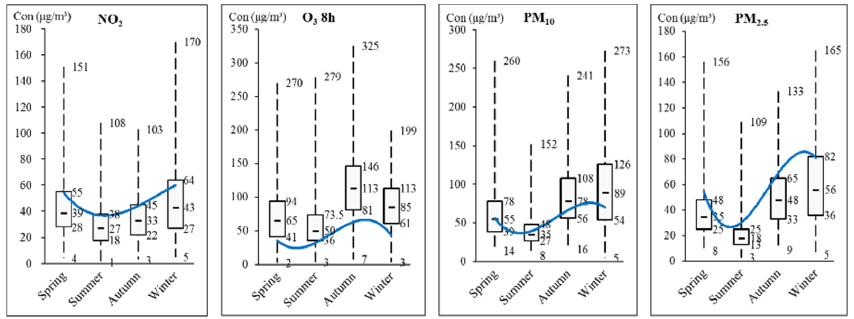
Figure 4. Seasonal variation trend of air pollutants in Shenzhen from March 2013 to February 2014.